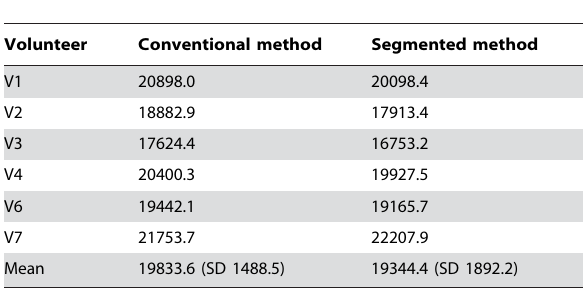
Table 1. Total surface areas obtained with the conventional and segmented methods.